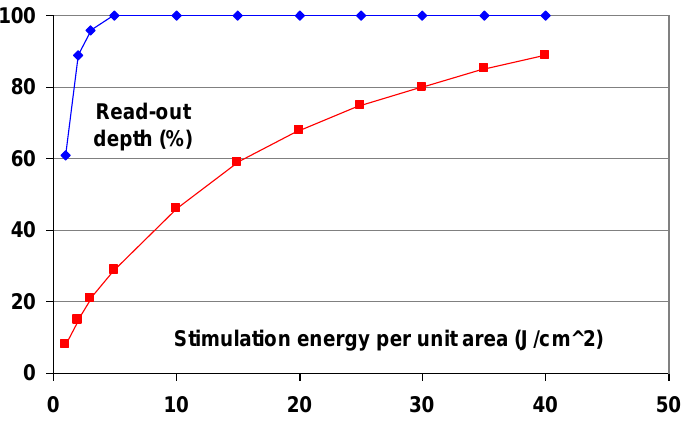
Figure 24. Read-out depth as a function of read-out energy for CsBr:Eu 2+ and BaFBr:Eu 2+ (data from